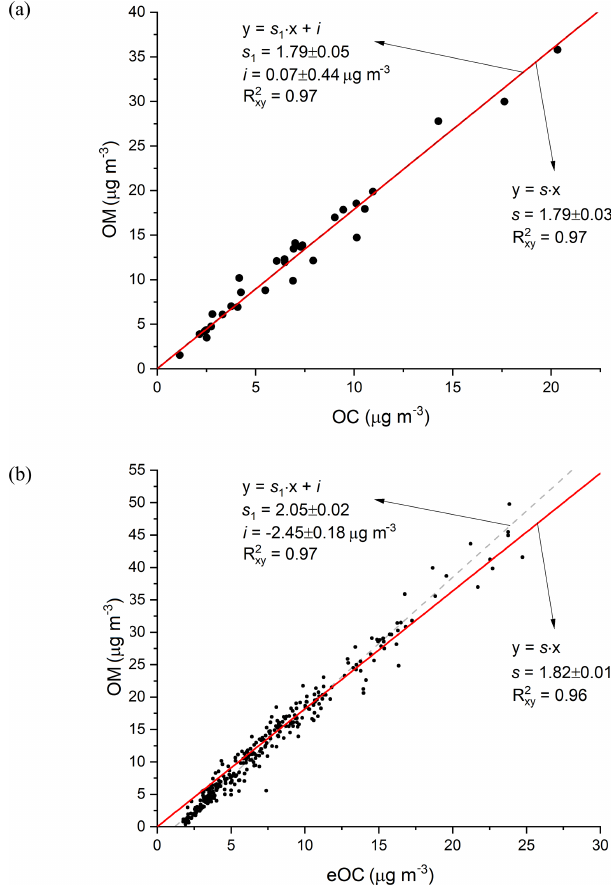
Figure 11. (a) Comparison of offline measurements of OC (lab- oratory filter analysis) using the EUSAAR_2 thermal protocol to the 24h average of online measurement of OM data taken by the ACSM. A total of 31 filter samples were collected for analysis dur- ing the campaign. Please note that the red trend line completely covers the dashed trend line ( s = s 1 ). (b) Comparison of 3h eOC data derived as eOC = TC − b BC to OM data measured by ACSM. Linear orthogonal regression results are shown with s as the slope (red line) for the model without an intercept and with s 1 as the slope and i as the intercept (dashed gray line) for the model with an in- tercept. R 2 xy is the square of the Pearson correlation coefficient. A total of 300 data points are used in the regression